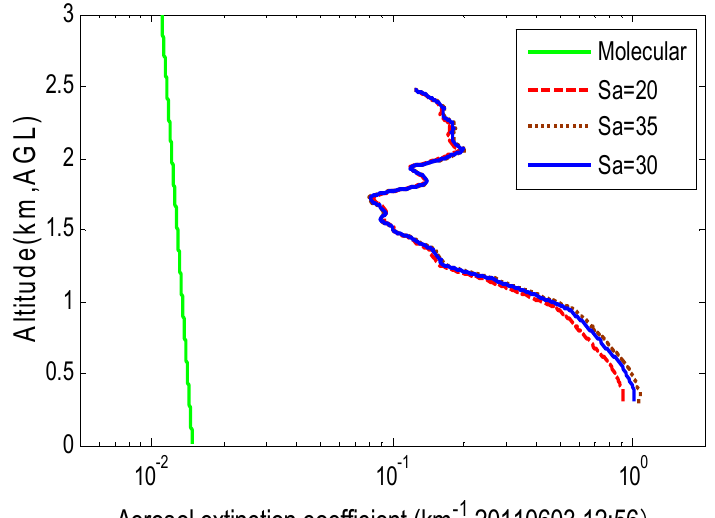
Figure 10. The extinction coefficient profiles retrieved with different Lidar